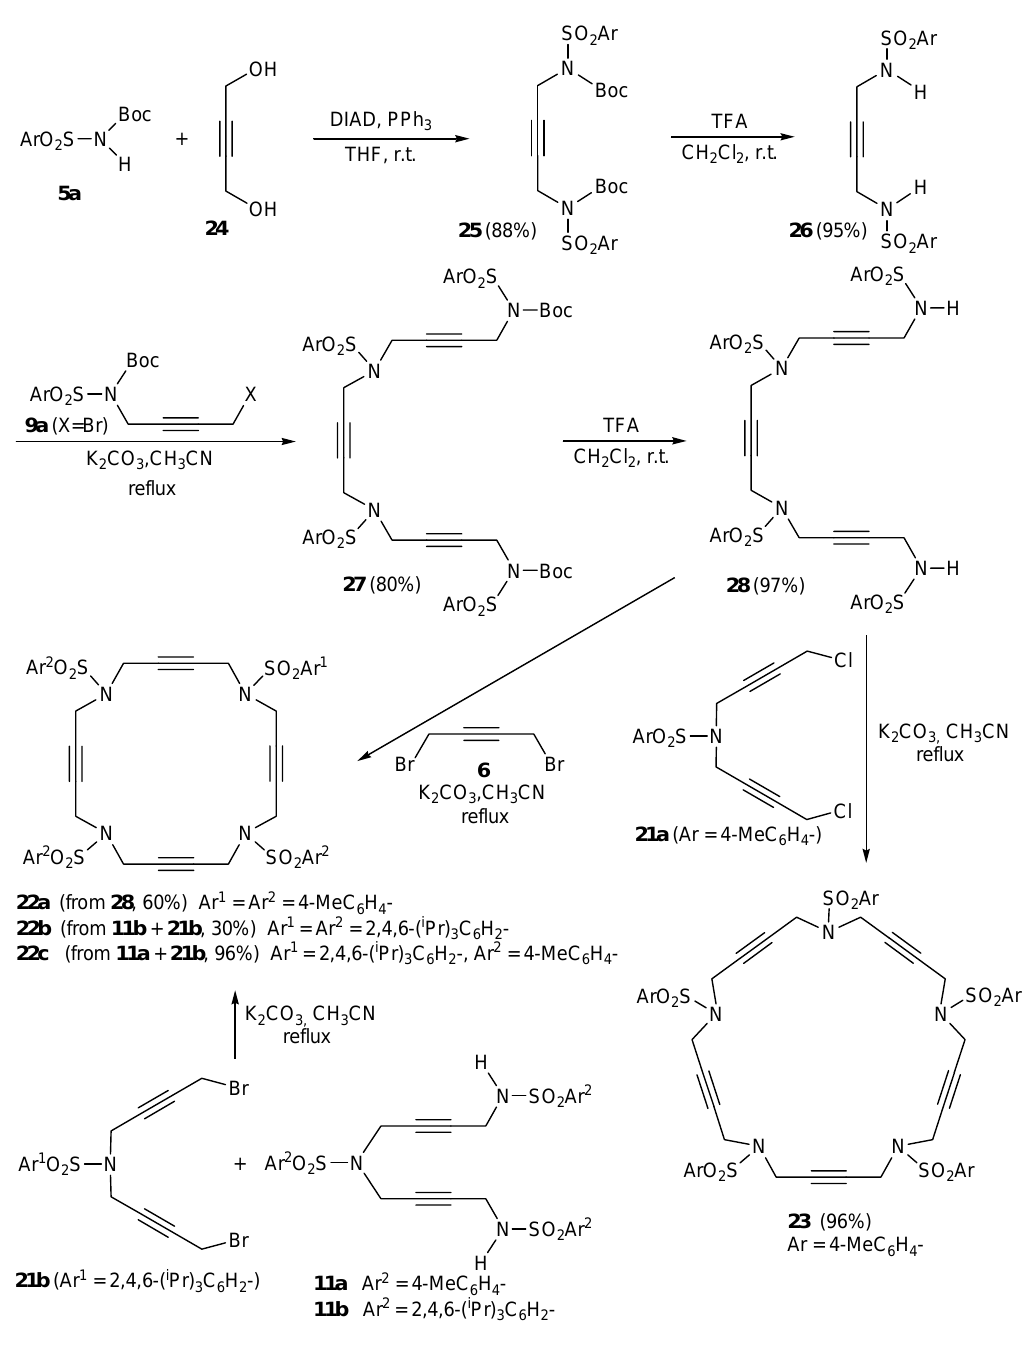
Scheme 6. Synthesis of macrocycles 22a-c and 23